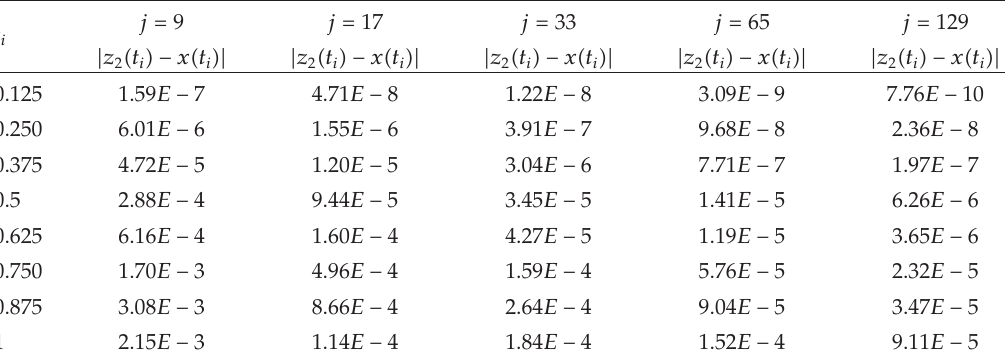
Table 2: Absolute errors for Example 4.2.